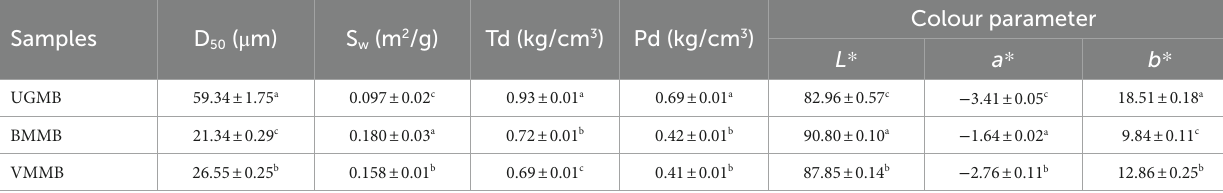
TABLE 1 Particle size distribution, specific surface area, particle density and